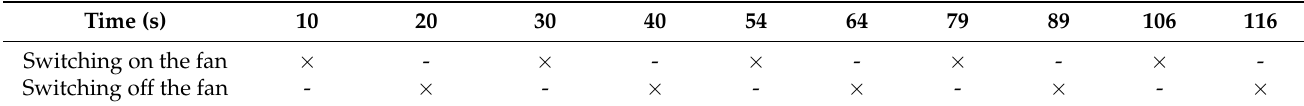
Table 3. The times of switching on/off the fan in experiment 3.